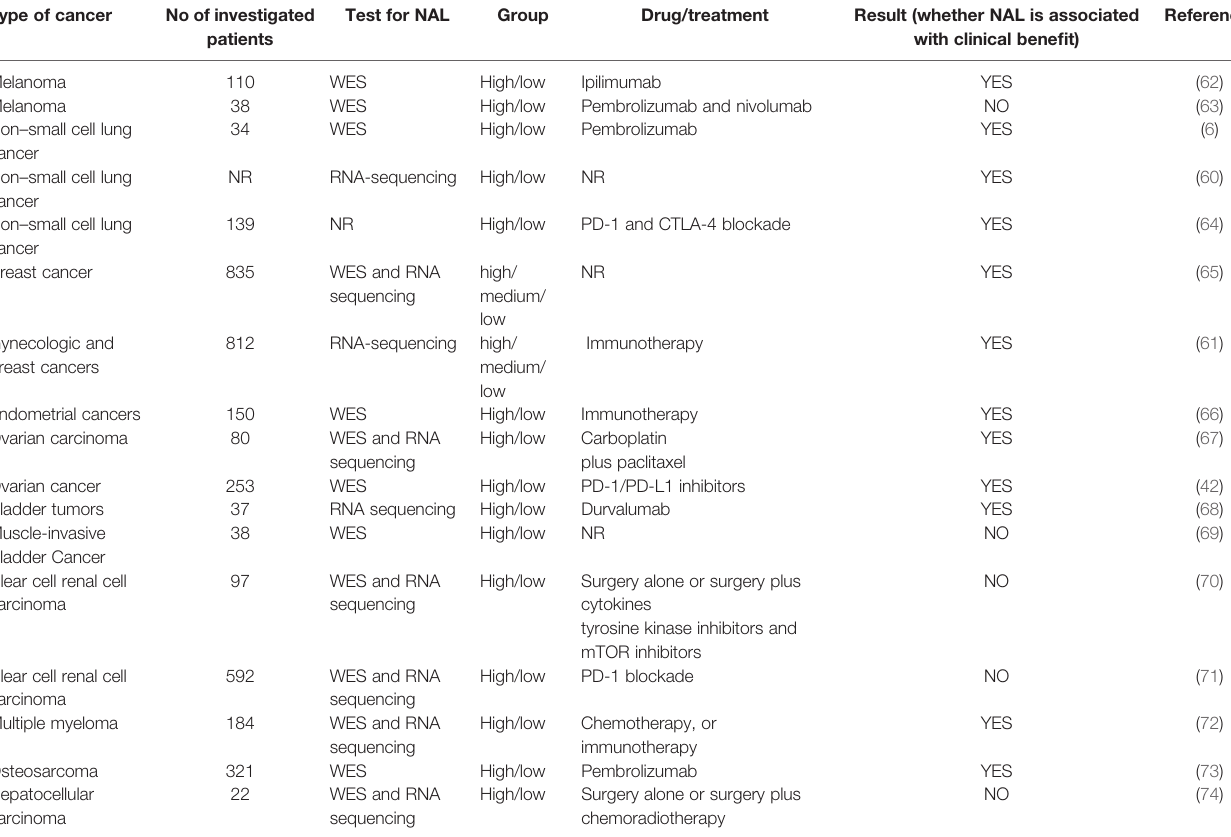
TABLE 1 | Studies describing the impact of neoantigen load evaluation in the clinical research. Type of